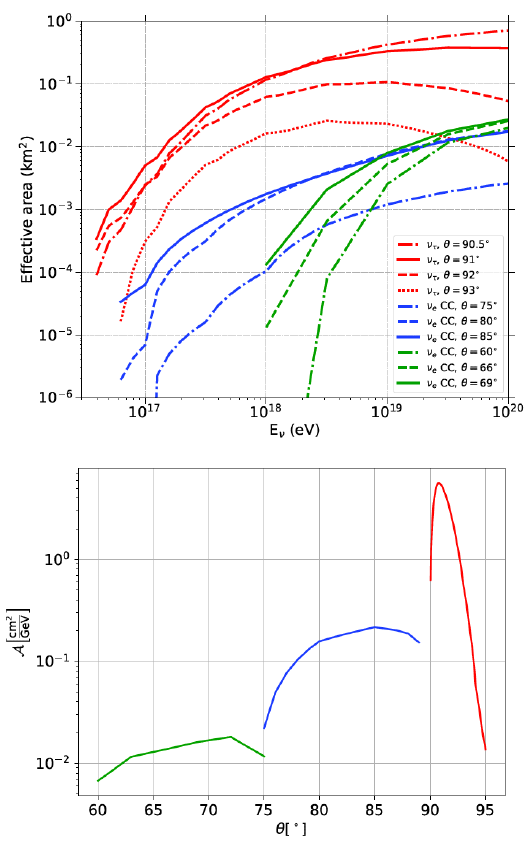
Figure 6. Top: the neutrino e ↵ ective area of the Pierre Auger Ob- servatory for various zenith angles, averaged over the year 2016. Bottom: The 2016 average of the neutrino e ↵ ective area folded E  2 neutrino energy spectrum. Colors code with the assumed / as in the top panel